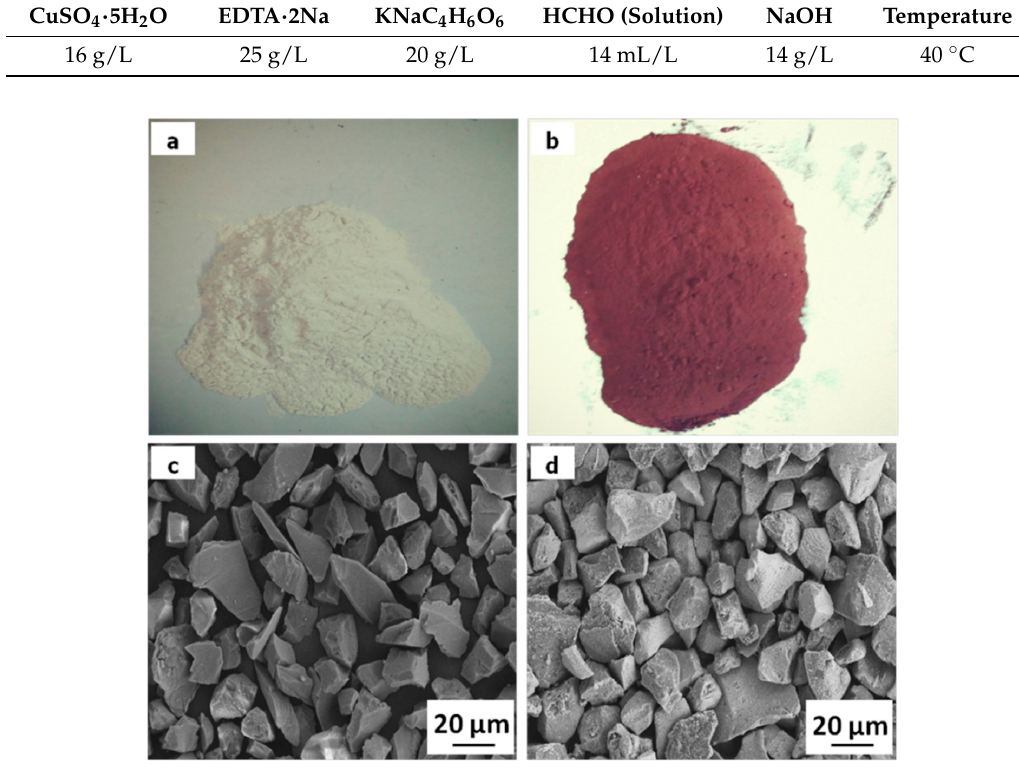
Figure 1. Macro and micro morphologies of SiO 2 : ( a ) and ( c ) uncoated; ( b ) and ( d ) Cu-coated.